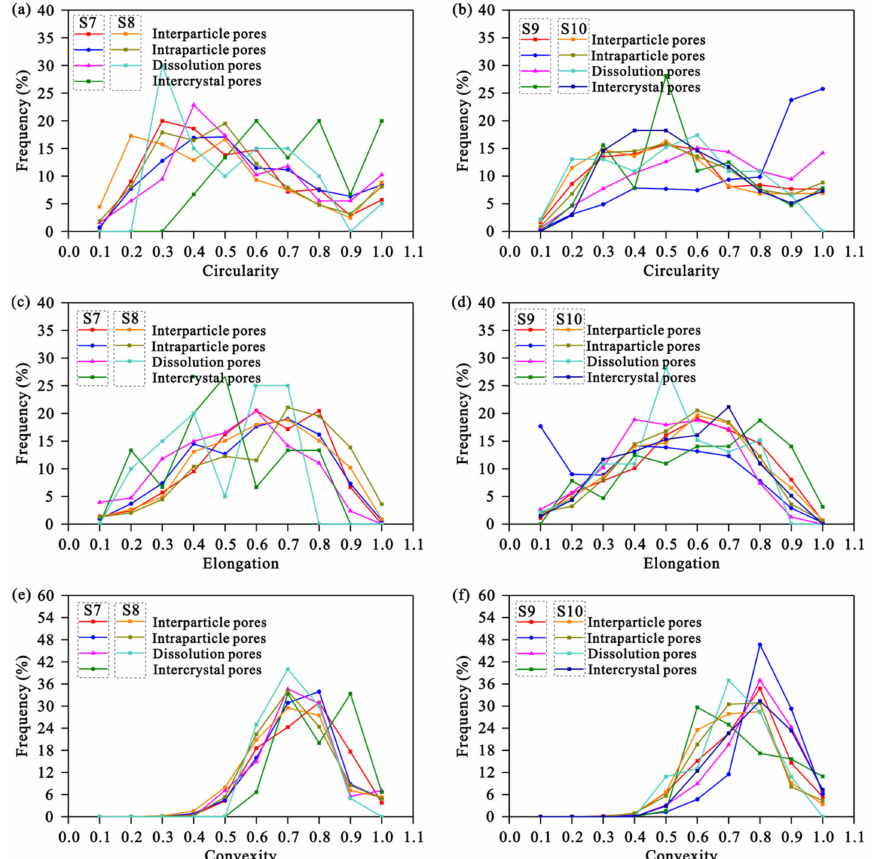
Figure 13. Pore morphology parameters in calcareous shales: ( a ) Circularity distribution of S7 and S8; ( b ) Circularity distribution of S9 and S10; ( c ) Elongation distribution of S7 and S8; ( d ) Elongation distribution of S9 and S10; ( e ) Convexity distribution of S7 and S8; ( f ) Convexity distribution of S9 and